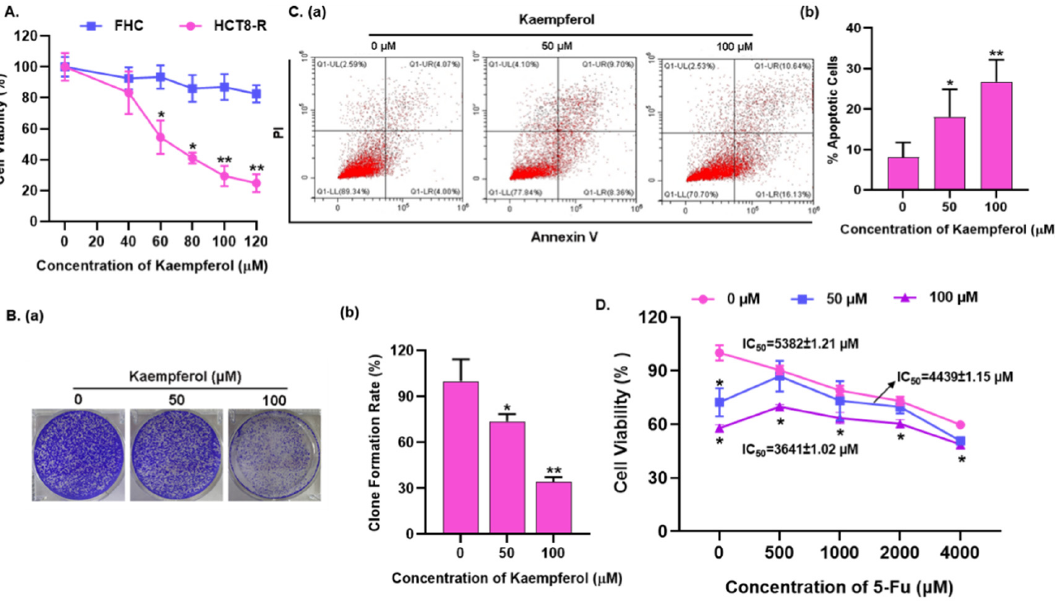
Figure 2. Kaempferol reverses the 5-Fu resistance in HCT8-R cells. ( A ) HCT8-R and FHC cells were treated with increasing concentrations of kaempferol for 48 h, and the cell viability was determined by CCK-8 assay. The blank control group (0 µ M) represented 0.05% ( v/v ) DMSO (dimethyl sulfoxide). Data represent means ± SD from three independent experiments. ( B ) HCT8-R cells were seeded into a 6-well plate at a density of 5 × 10 3 /well and treated with various doses of kaempferol for one week; then the cell clone formation ability was explored. ( a ) Representative graphs are shown. ( b ) The quantitative analysis of colony formation. ( C ) Analysis of apoptosis in HCT8-R cells treated with kaempferol for 48 h using flow cytometry. ( a ) Representative graphs are shown. ( b ) The apoptotic rate is shown in bar format. ( D ) HCT8-R cells were pretreated with different concentrations of kaempferol for 24 h, then treated with 5-Fu for another 24 h, and the cell survival rate was determined by CCK-8 assay. * p < 0.05, ** p < 0.01.